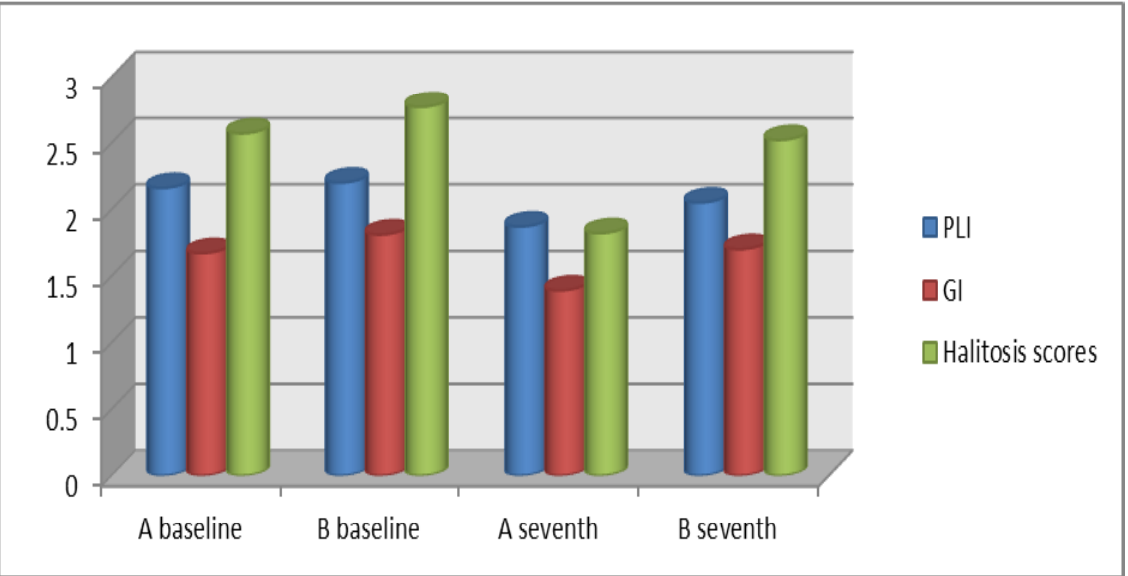
Figure 1: The mean values of the variables of the sample among the study groups